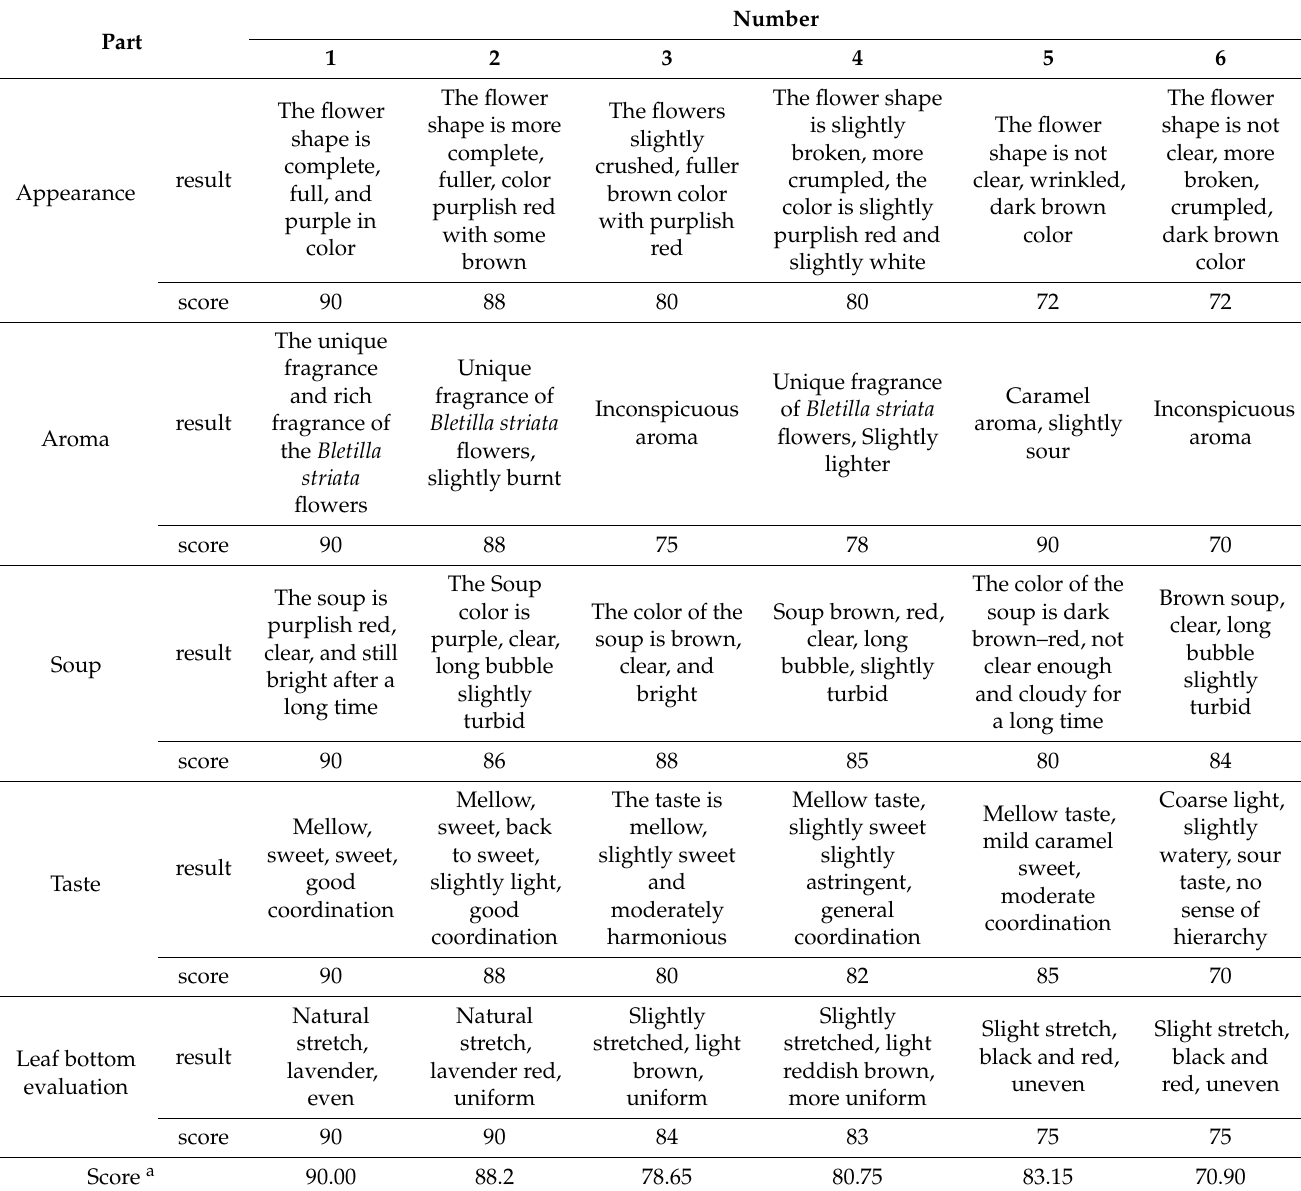
Table 1. Sensory evaluation results of Bletilla striata flowers.